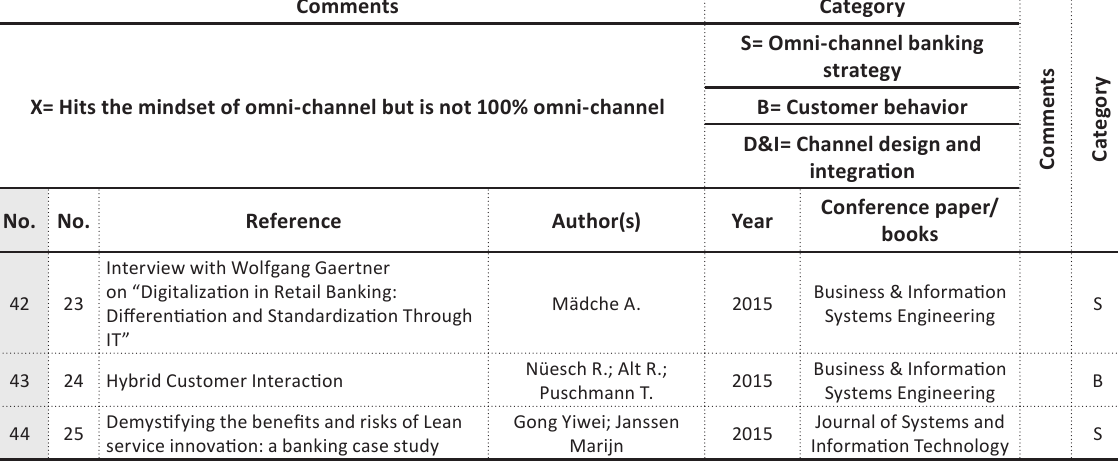
Table A1 (cont.). Omni-channel in the context of banking literature, search phases 3.1,